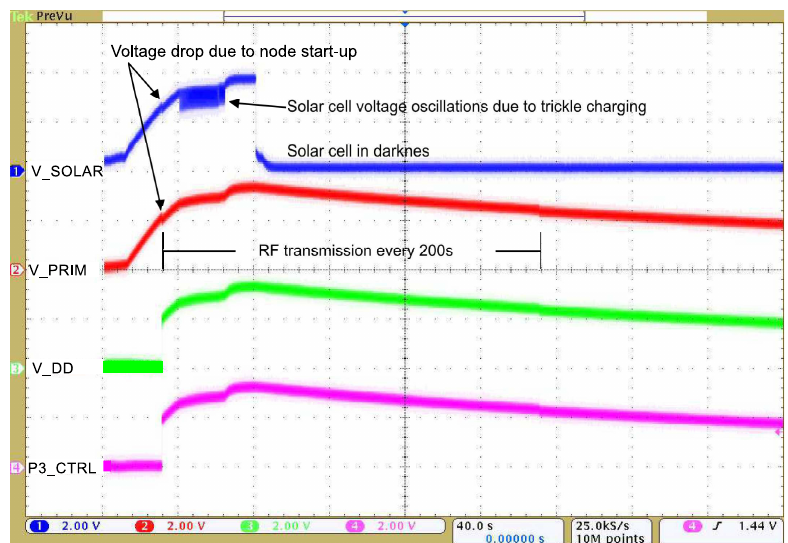
Figure 6. System cold boot and one complete operating cycle at illumination level of 1000lx (office environment under daylight). Waveforms are acquired at points denoted in Figure 1. When the WSN node receives power, the microcontroller goes through the power–up procedure which is followed by the RF module configuration, data acquisition and transmission. A closer view of the start–up period is shown in Figure 7.